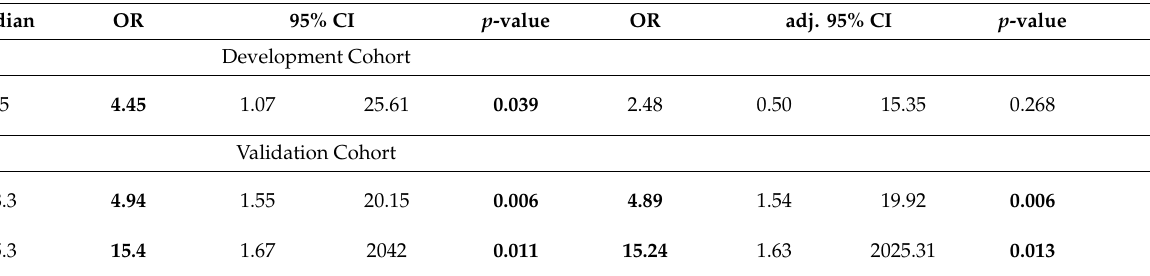
SLPI measured at 24 h for AKI diagnosed later: 48 or 72 h after surgery (11 of 14 cases of